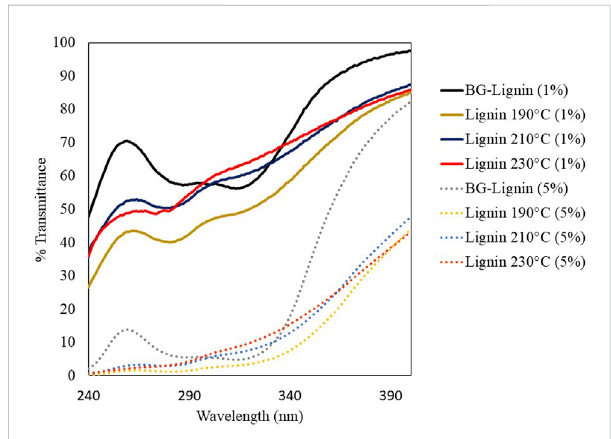
FIGURE 4 UV transmittance of solvent (70%v/v ethanol) containing 1%w/v and 5%w/v organosolv lignin extracted from bagasse prior and after thermal modi fi cation.